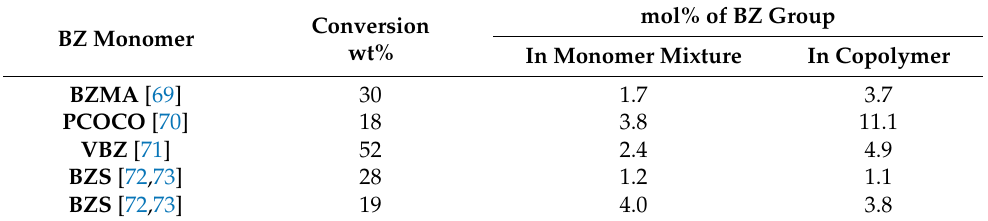
Table 2. Compositions of BZ -bearing monomer and styrene mixtures and their copolymers. mol% of BZ Group Conversion BZ Monomer wt% In Monomer